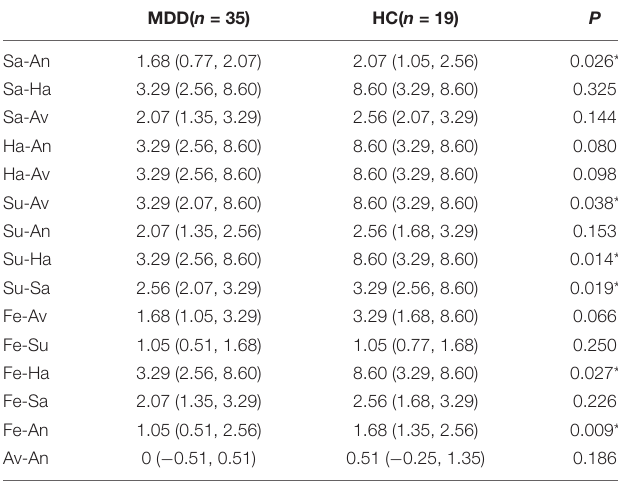
TABLE 2 | Facial expression recognition d (cid:48) values of MDD and HC